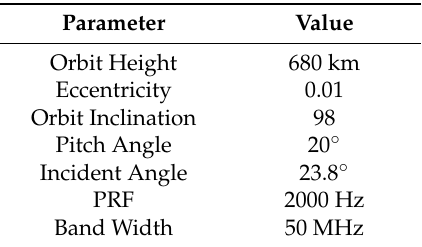
Table 2. Simulation